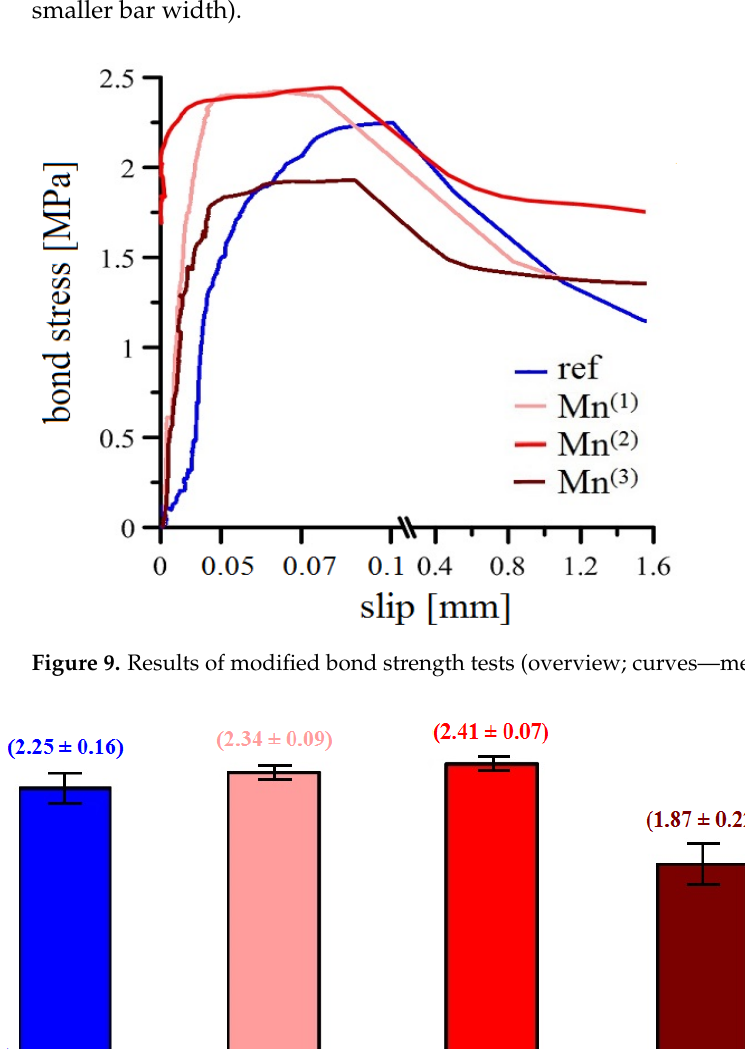
(15) Table 7. Description of individual variables from Equation (14). Symbol